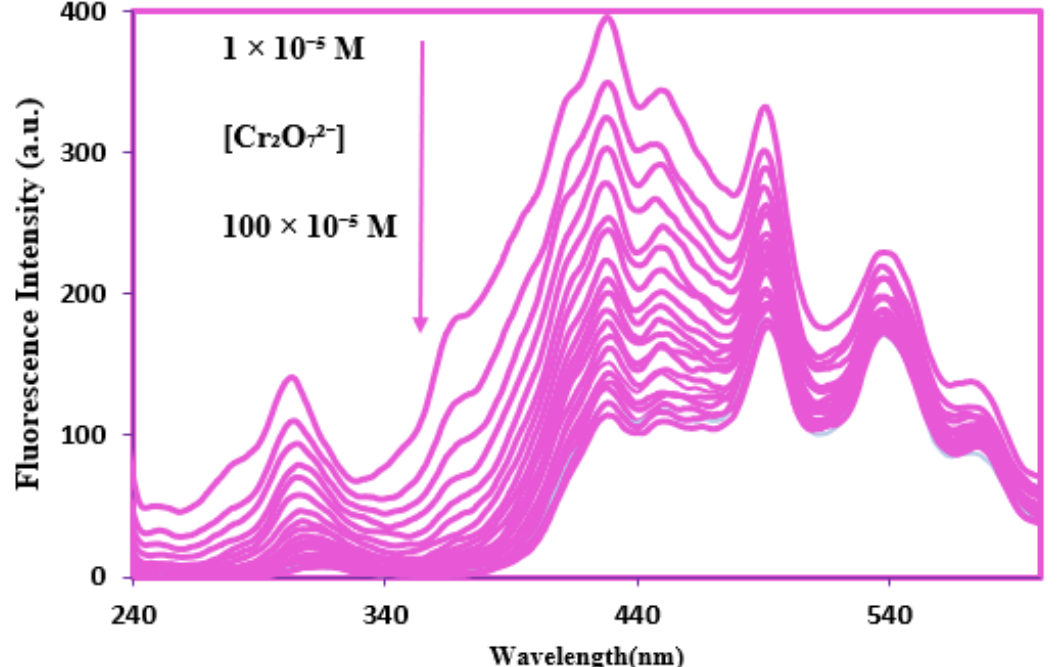
Figure 13. Fluorescence response of SBA-Pr-Is-TAP (3 mL H ₂ O suspension, 0.2 g L − ¹) upon the addition of various concentrations of Cr ₂ O ₇ ² ⁻ .